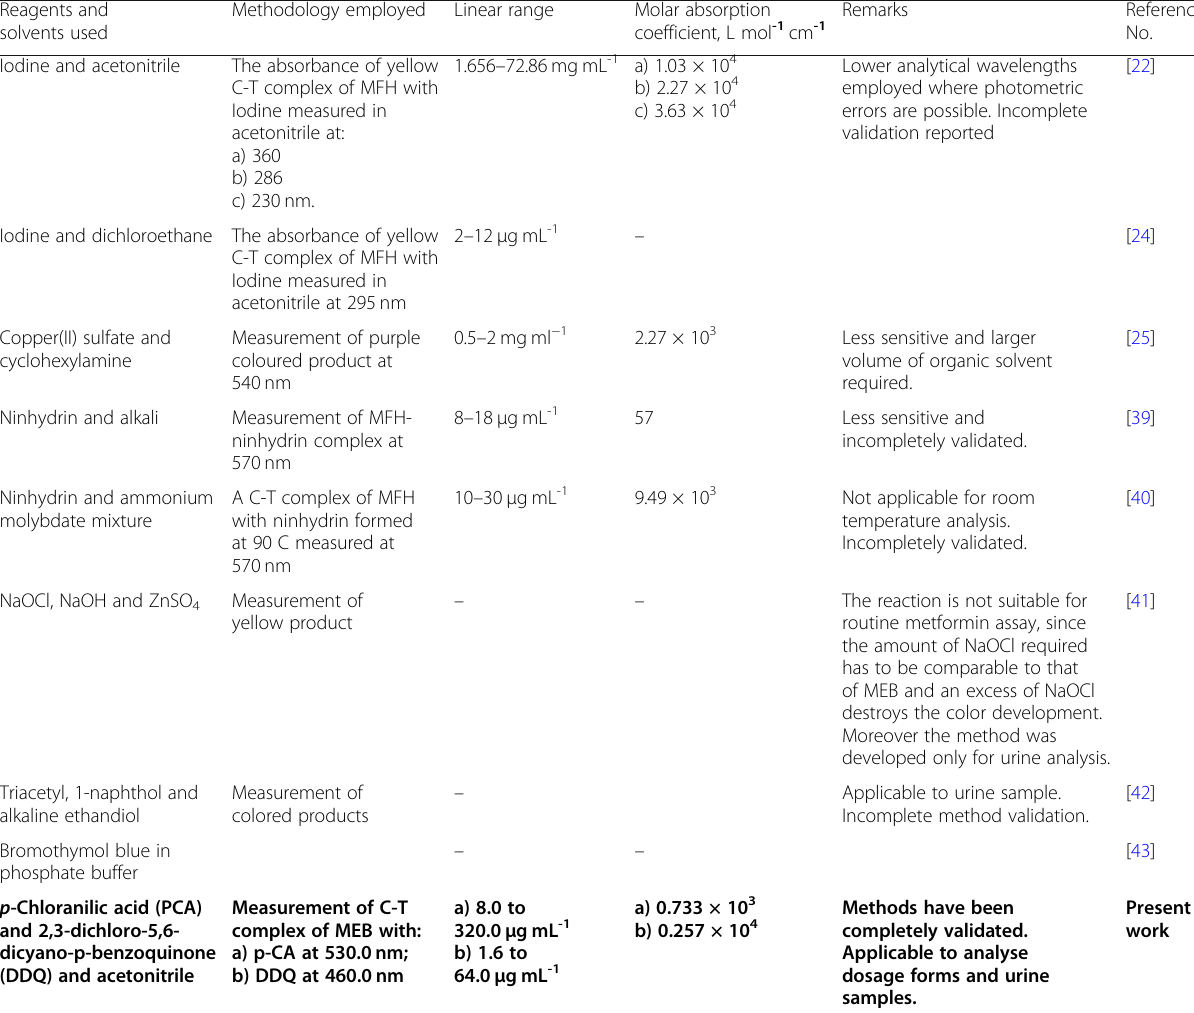
Table 8 Details with performance characteristics of reported visible spectrophotometric methods Reagents and solvents